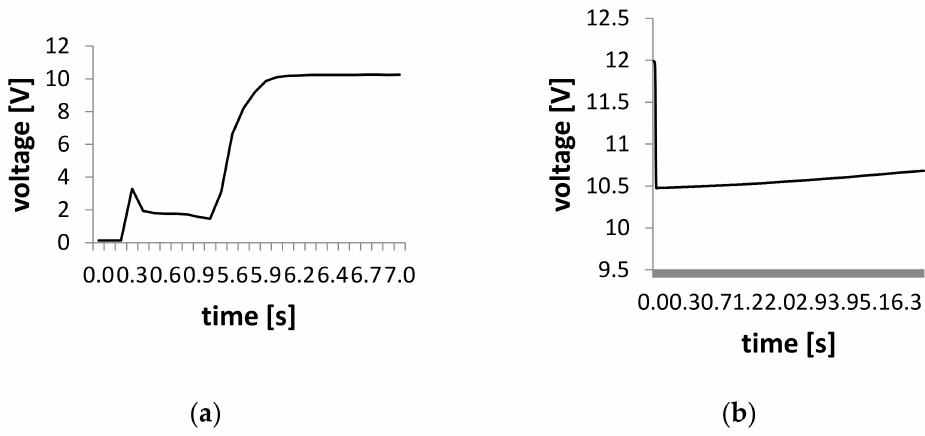
Figure 9. Fuel cell voltage characteristic during start-up. Measurements of the physical object ( a ), simulation ( b ).